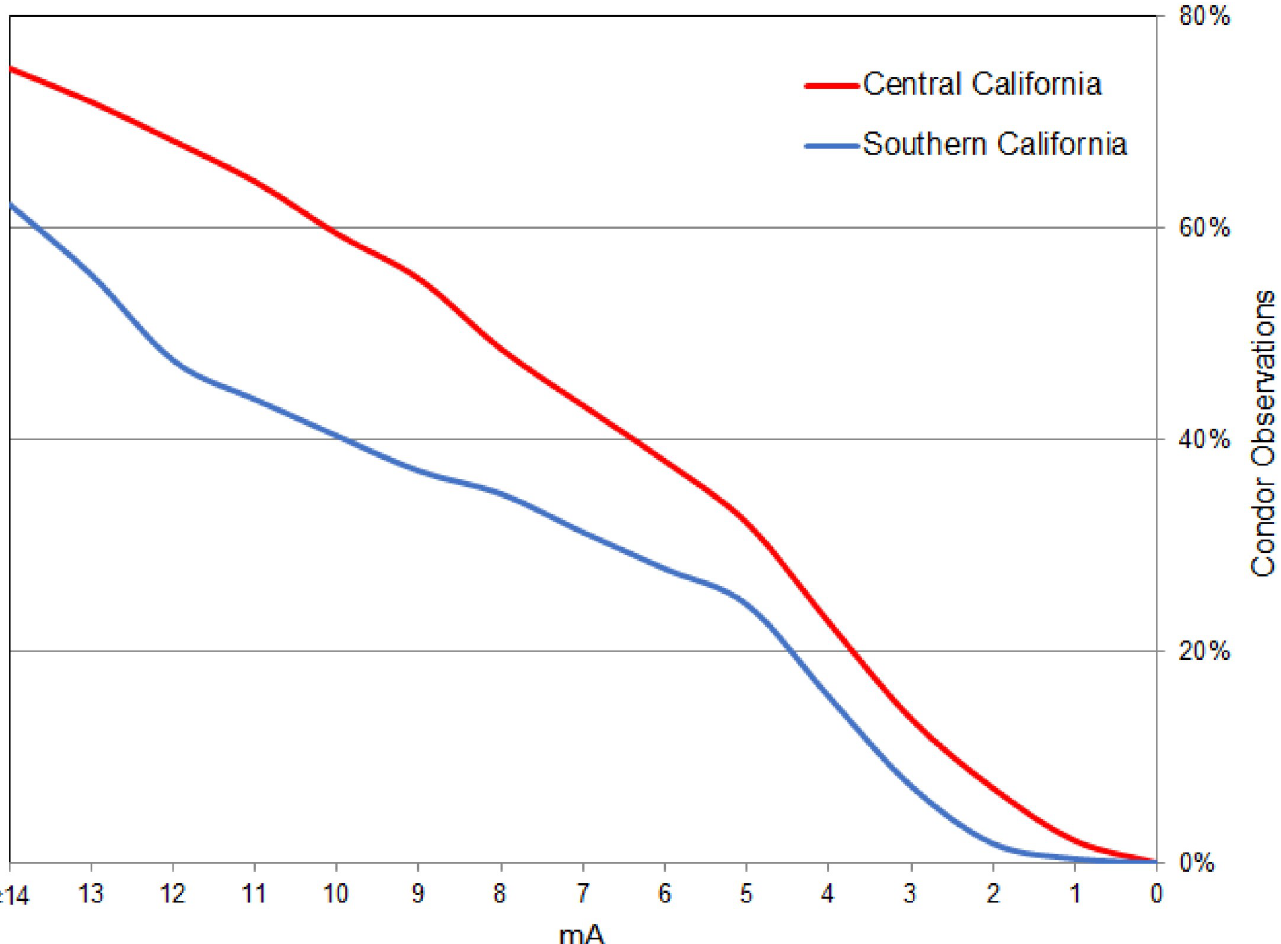
Fig 4. Reverse cumulative frequency plot of in-flight California condor locations (July 2013-May 2017) in relation to electrical current for the southern and central California modeling regions,